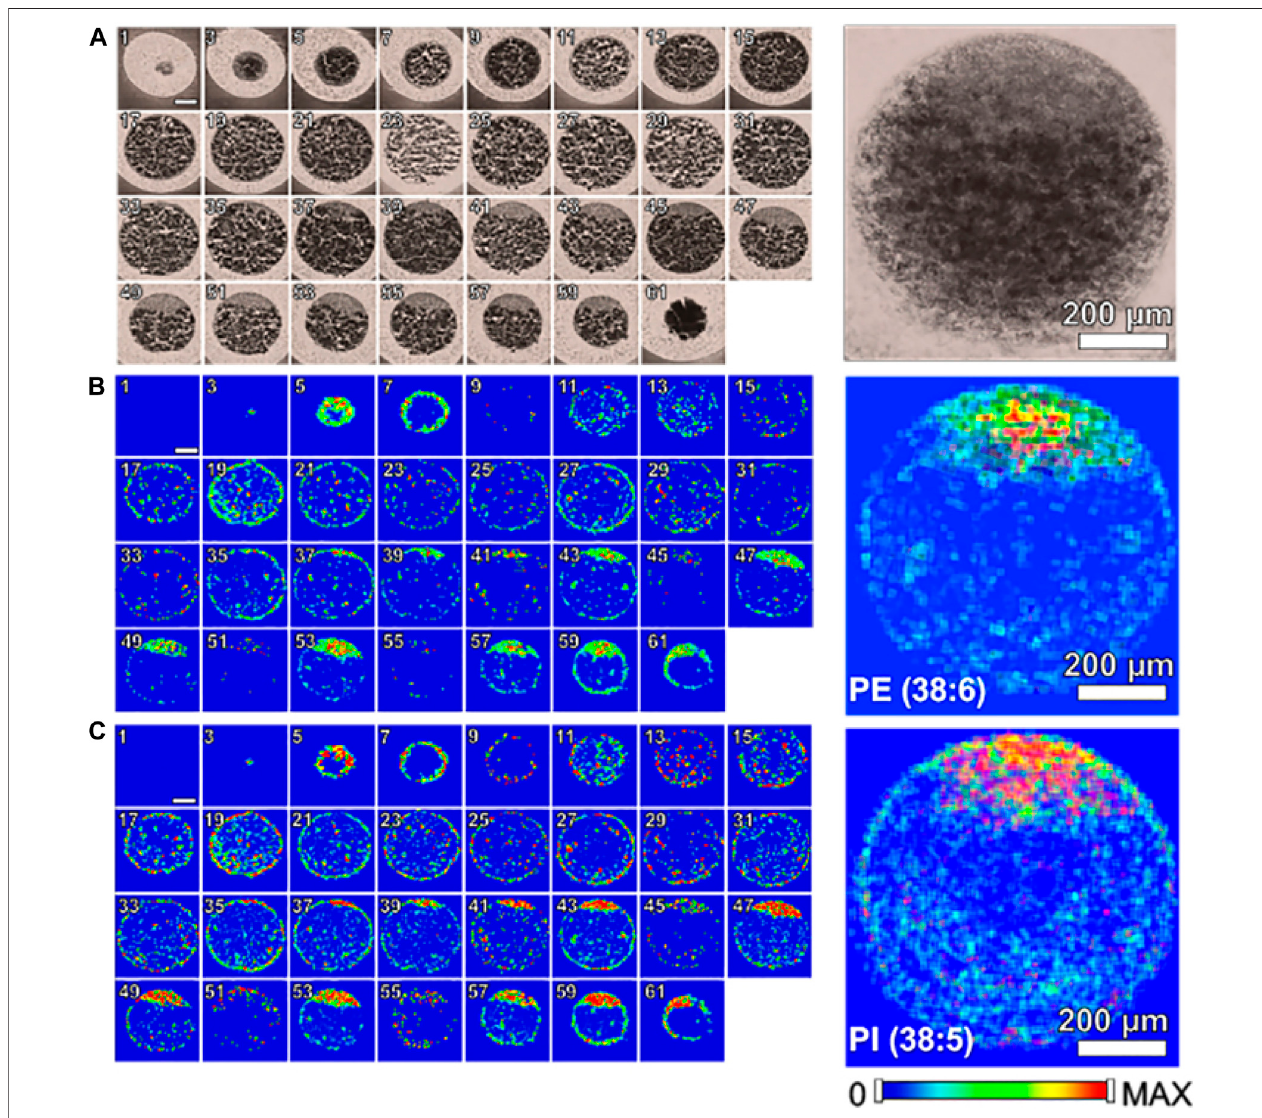
FIGURE 6 | Single cell molecular mapping Zenobi, 2013. Odd numbered optical images of fertilized zebra fi sh embryo at the one-cell stage, false color two- dimensional MALDI-MS images of PE (22:6_16:0) at m/z 762.509 and PI (18:0_20:5) at m/z 883.535, and projected images are shown on the right by overlaying all 2D images (Duenas et al.,